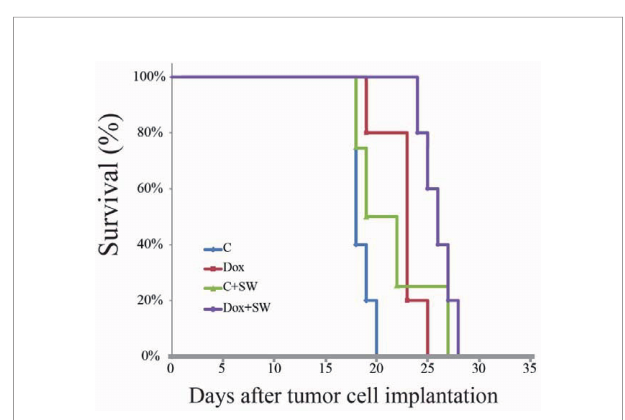
FIGURE 5 | Kaplan-Meier survival curves of C6 tumor-bearing mice treated with different group (Control, Dox, SW, Control +SW and Dox+SW). SW, shockwave; Dox,